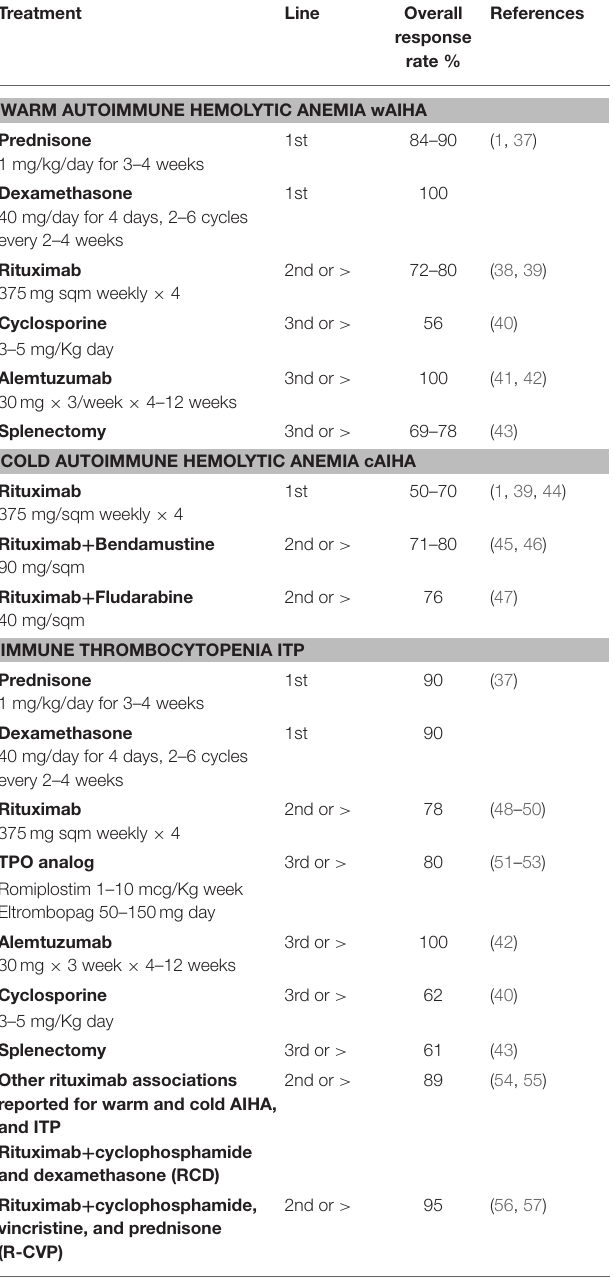
TABLE 1 | Specific therapies and relative outcomes for warm and cold autoimmune hemolytic anemia and immune thrombocytopenia secondary to chronic lymphocytic leukemia